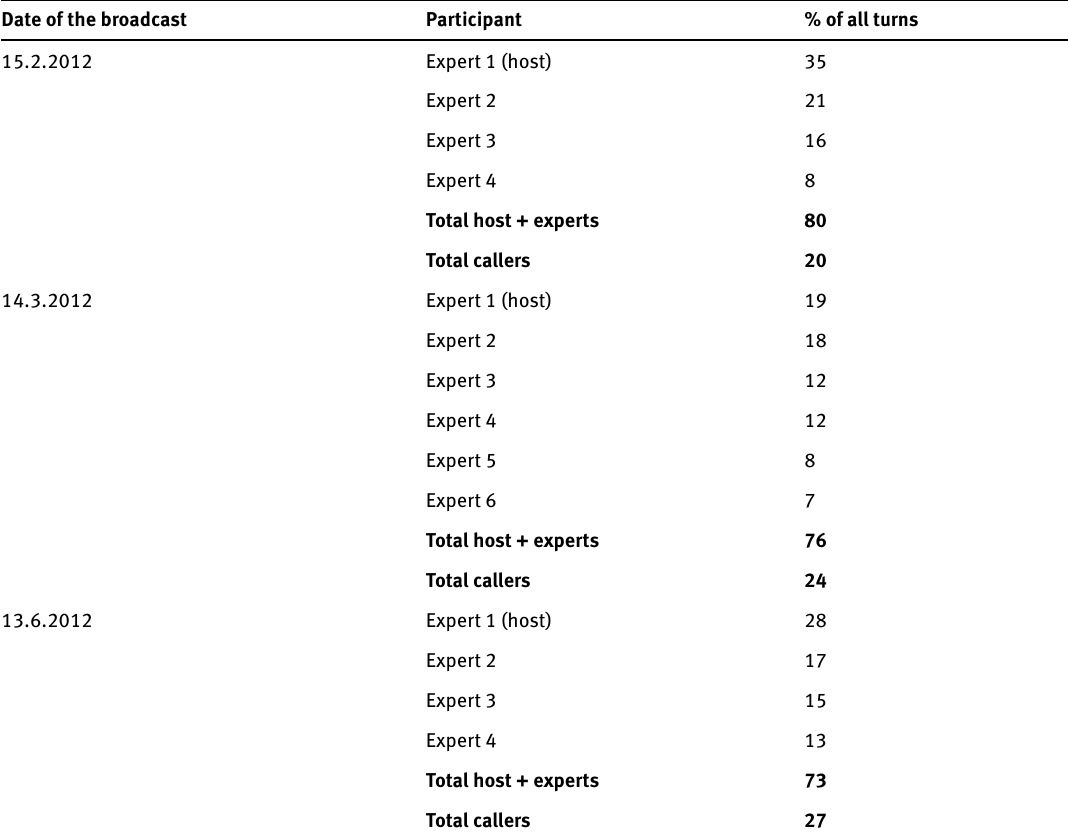
Table 2. The distribution of turns by participant in the Luontoilta conversations Date of the broadcast